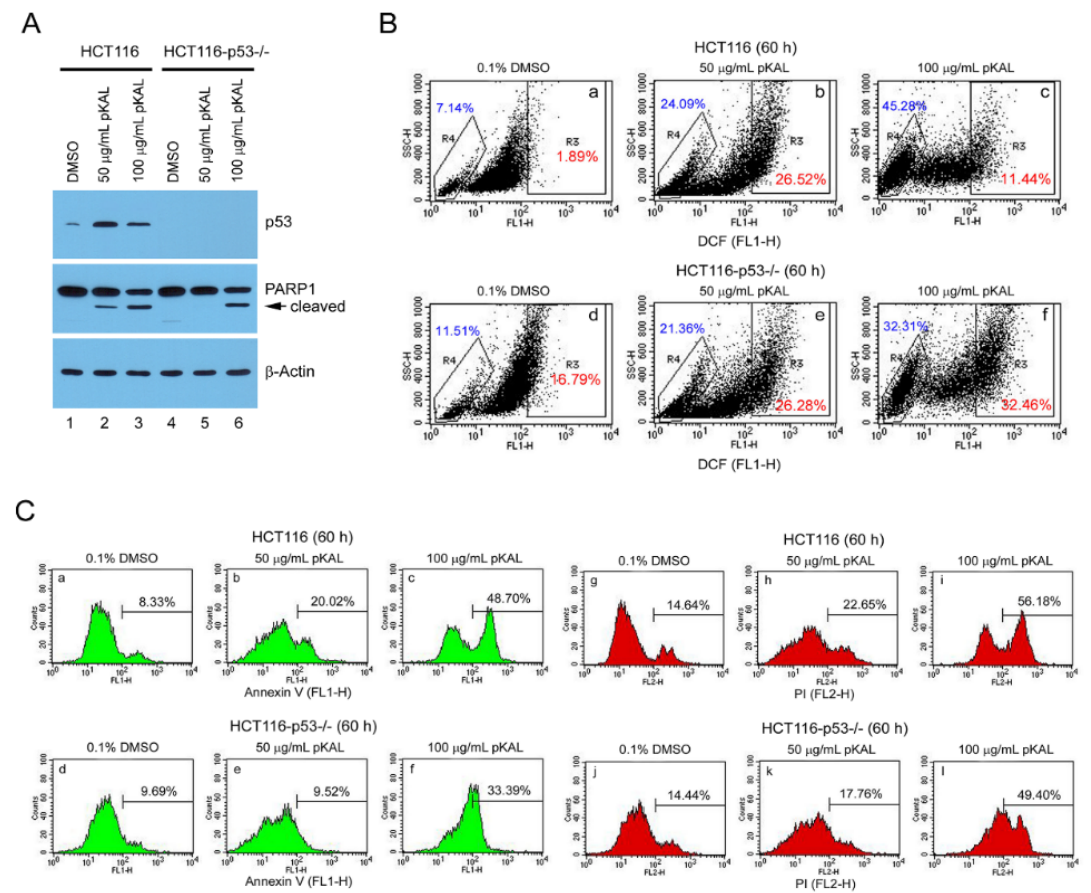
Figure 4. Comparison of pKAL effects on PARP1 cleavage, ROS production, and apoptosis between p53-wild and p53-null HCT116 cells. ( A ) HCT116 and HCT116-p53 − / − cells were grown for 12 h, and then treated with the indicated concentrations of DMSO or pKAL for 48 h. Cells were analyzed by Western blot using p53, PARP1 and β -actin antibodies. ( B , C ) HCT116 and HCT116-p53 − / − cells were grown for 60 h at the indicated concentration of DMSO or pKAL: ( B ) Flow cytometric analysis of DCF-stained cells; ( C ) Flow cytometric analysis of annexin V / PI-stained cells.